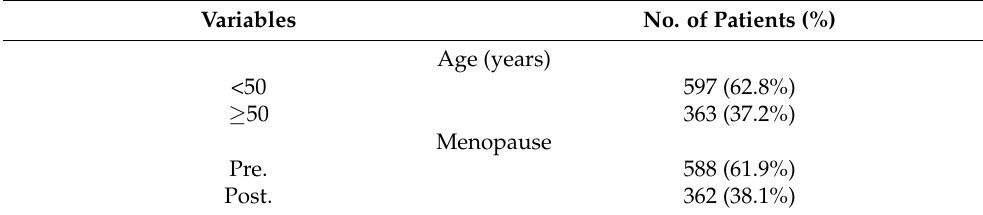
Table 1. Clinicopathological characteristics of breast cancer